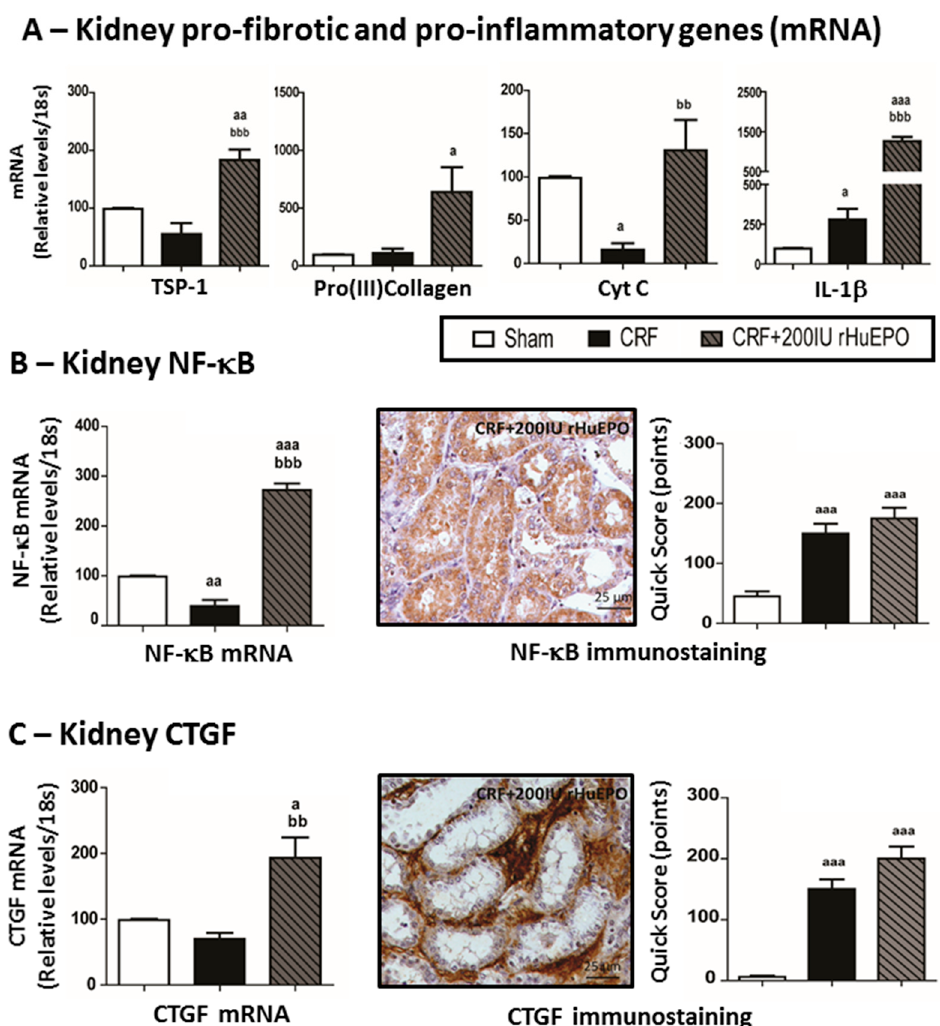
Figure 6. Kidney expression of mediators of inflammation and fibrosis. Gene (mRNA) expression of thrombospondin-1 (TSP-1), pro-(III) collagen, cytochrome c (Cyt C) and interleukin 1 β (IL-1 β ) ( A ). Kidney expression of nuclear factor kappa B (NF- κ B) gene and protein (immunohistochemical staining) ( B ) and connective tissue growth factor (CTGF) gene and protein ( C ). Original magnification × 400. Results are presented as mean ± SEM (seven rats per group): a: p < 0.05, aa: p < 0.01, and aaa: p